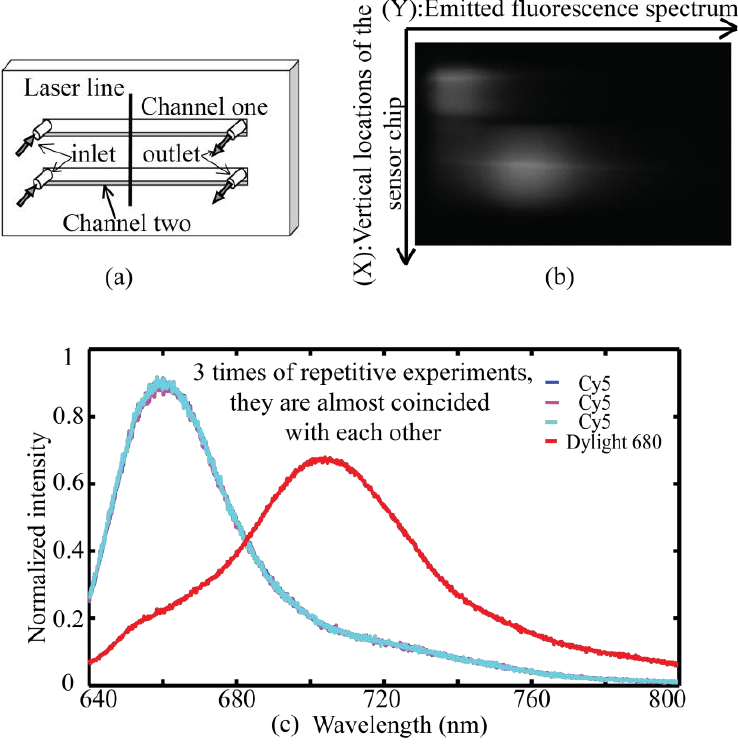
Figure 3. Demonstration of the data processing. ( a ) Structure of the two flow channels and the focused laser line; ( b ) An image captured by CCD, corresponding to the irradiated line region; ( c ) Fluorescence spectra correspond to channel one and channel two separately. Thicknesses for the three successive layers of MgF 40 nm, 600 nm